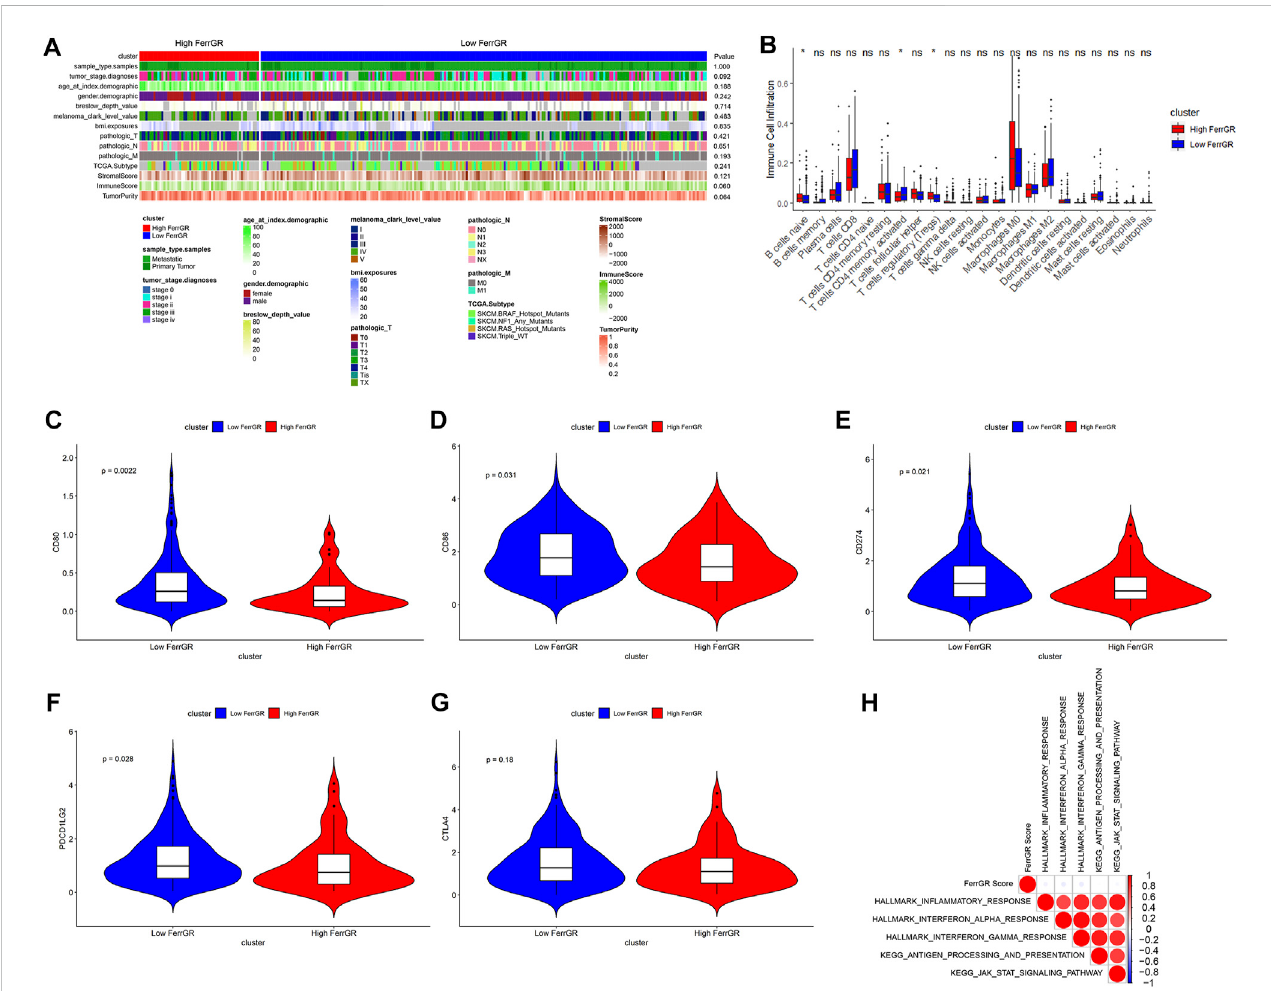
FIGURE 7 Tumour immune microenvironment analysis of FerrGR model. (A) The heatmap showed the correlations between FerrGR score and clinicopathological features. (B) Boxplot exhibitedthedistributionpatterns ofimmunecell in fi ltration between twoFerrGRgroups. (C – G) violin plots visualizing theexpression of immunecheckpointgenesinthehigh — andLow — FerrGRgroups, (C) CD80, (D) CD86, (E) CD274, (F) PDCD1LG2, (G) CTLA4 (H) Genesetenrichmentanalysis (GSEA) results depicting enrichment of immune-related pathways based on FerrGR